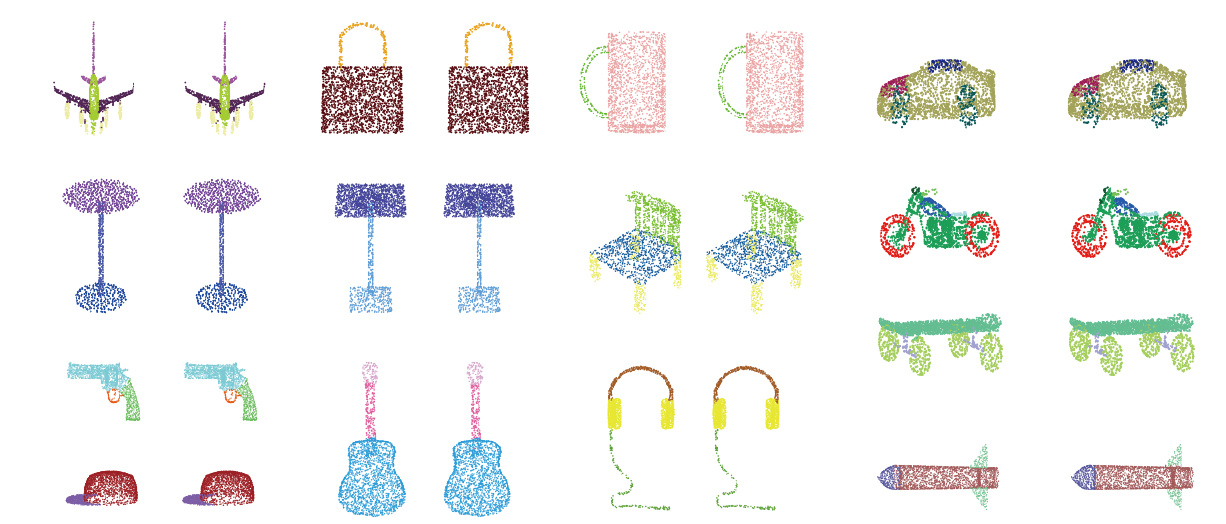
Figure 8. Segmentation examples of ShapeNet. For each sample, ( left column ) ground truth; ( right column )